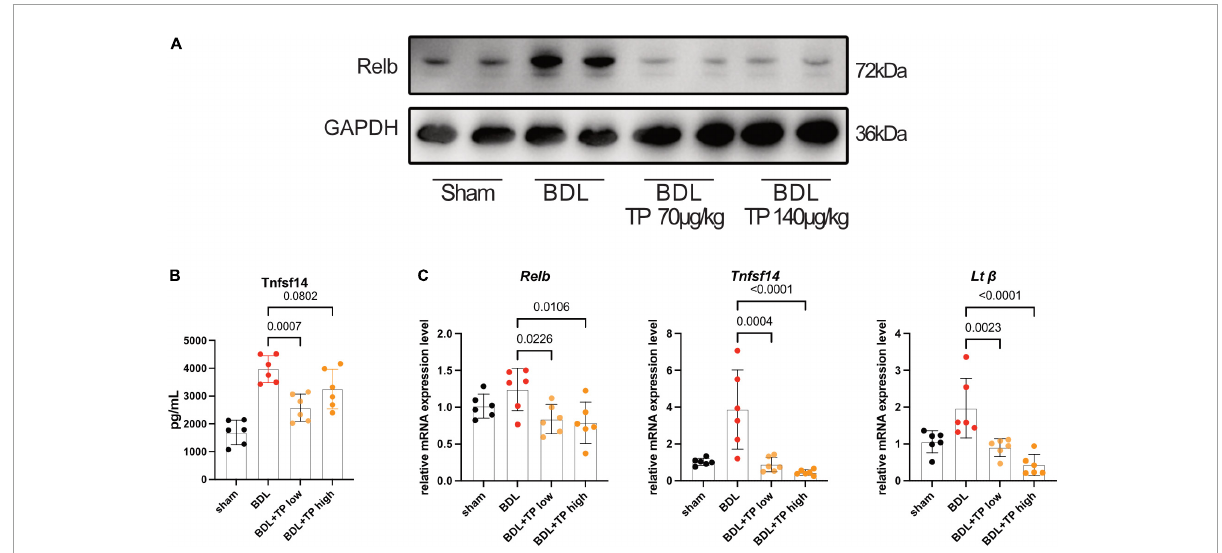
FIGURE3 Triptolide inhibits BDL induced RelB and its downstream gene expression. (A) Western blot analysis of RelB in liver. (B) The serum TNFSF14 levels (ELISA data) of mice. (C) The mRNA level of Relb , Tnfsf14 and Lt β in liver tissues. Data are shown as the mean ± SD. Data represent at least 6 independent experiments with triplicate measurements. Analysis of variance (one-way ANOVA) was used. p values represents significance different from BDL